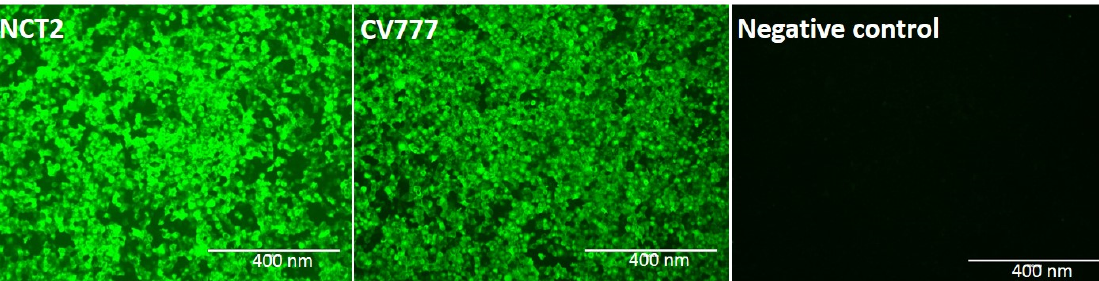
Figure 1. Reaction of mAb 5F7 with PEDV-positive cells, as detected by IFA. The cells infected by PEDV strains LNCT2 and CV777 yielded positive signals, and Vero E6 cells were used as negative controls. The heavy chain of mAb 5F7 was IgG2a, whereas the light chain was kappa, as determined by the SBA Clonotyping System-HRP (Southern Biotech). Bar, 400 μ m.